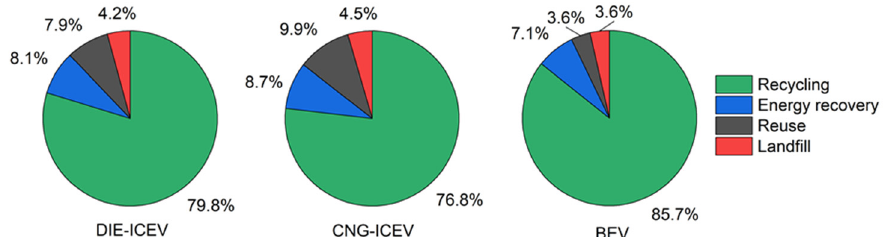
Figure 3. Rates of recycling, reuse, and incineration with energy recovery and landfilling for each